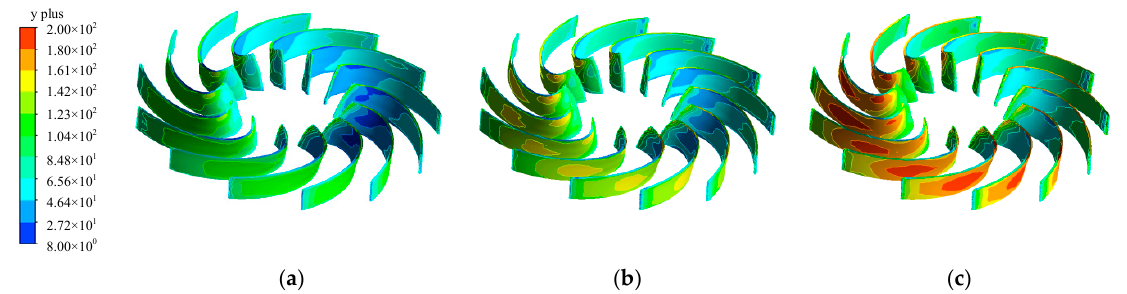
Figure 5. Three sets of mesh with different y plus distributions: ( a ) Mesh A with maximum y plus of 113; ( b ) Mesh B with maximum y plus of 158; ( c ) Mesh C with maximum y plus of 189.